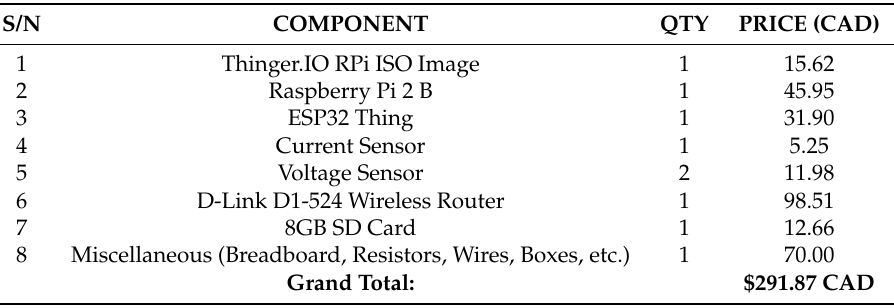
Table 1. Bill of